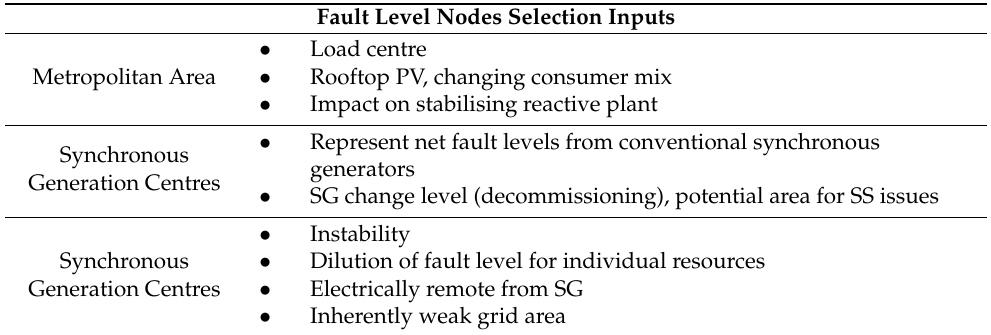
Table 3. Fault Level